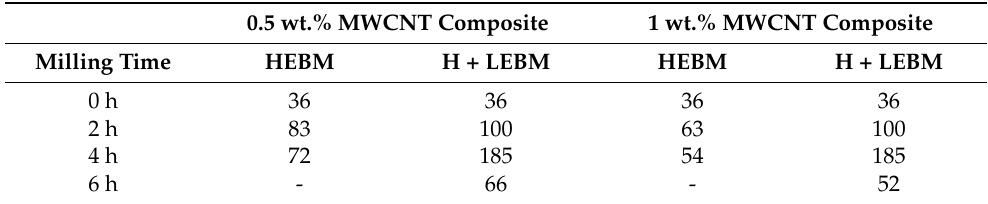
Figure 8. SEM micrographs of AA7075 + 1%-MWCNTs mixed with the LEBM method after different mill times: ( a , b ) 2 h; ( c , d ) 4 h. Table 3. Average particle size (in µ m) of the powders milled through different routes and with different MWCNT